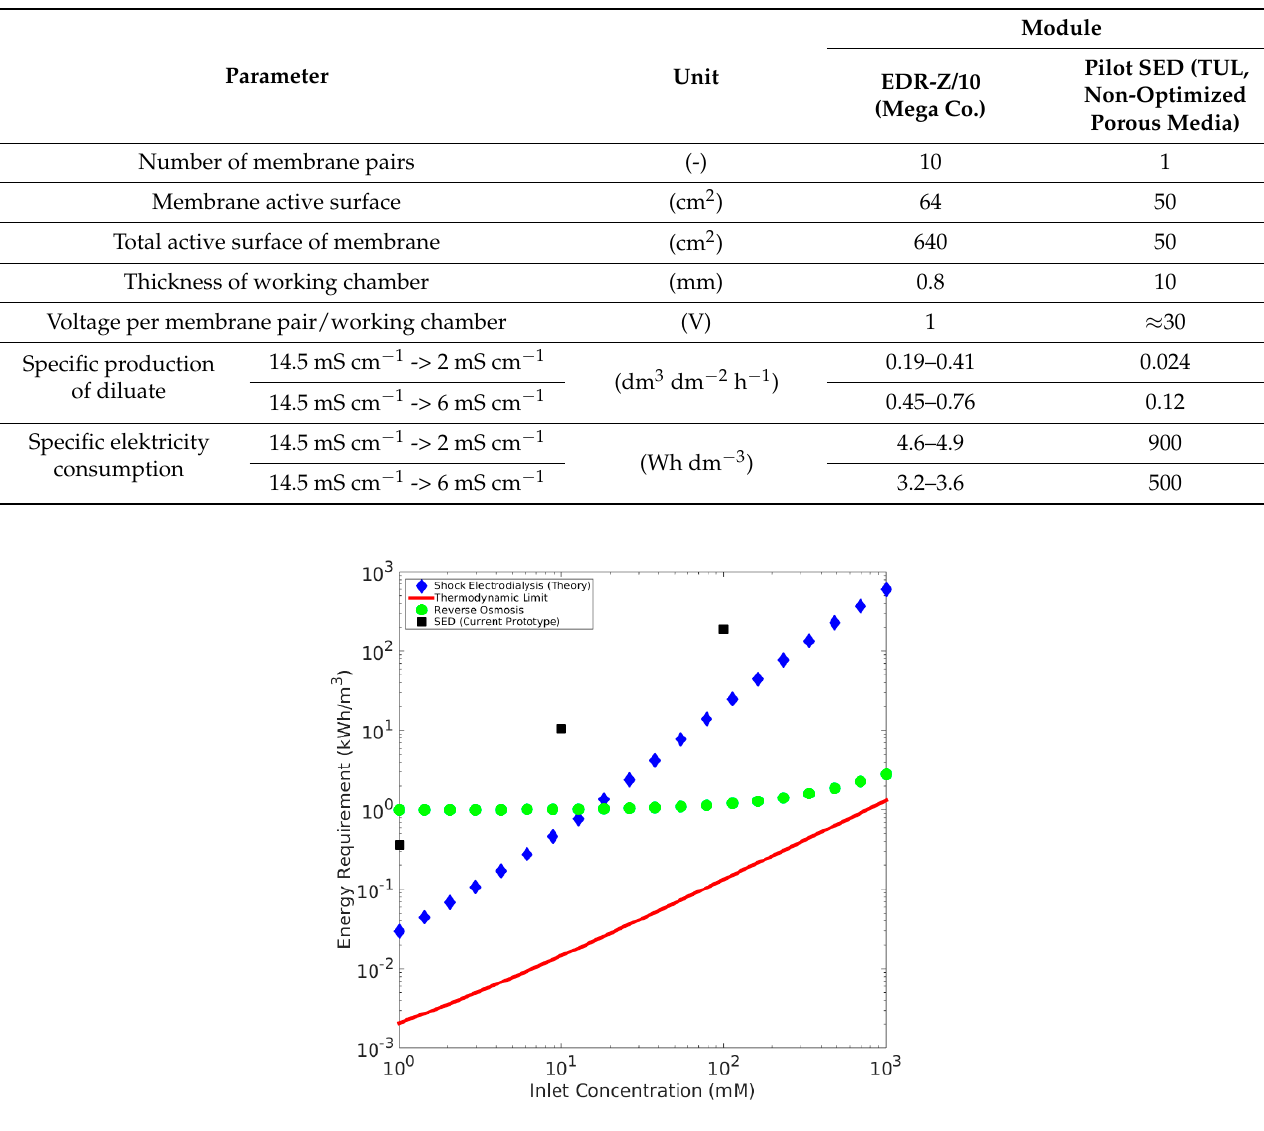
Figure 14. Very first calculation of energy requirements for SED, calculated and measured by Schlumpberger (Bazant‘s group at M.I.T., 2015) and compared to other desalination